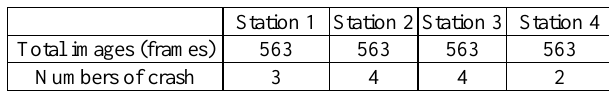
Table 2: Details of mobile camera image station frame capture over the stability monitoring